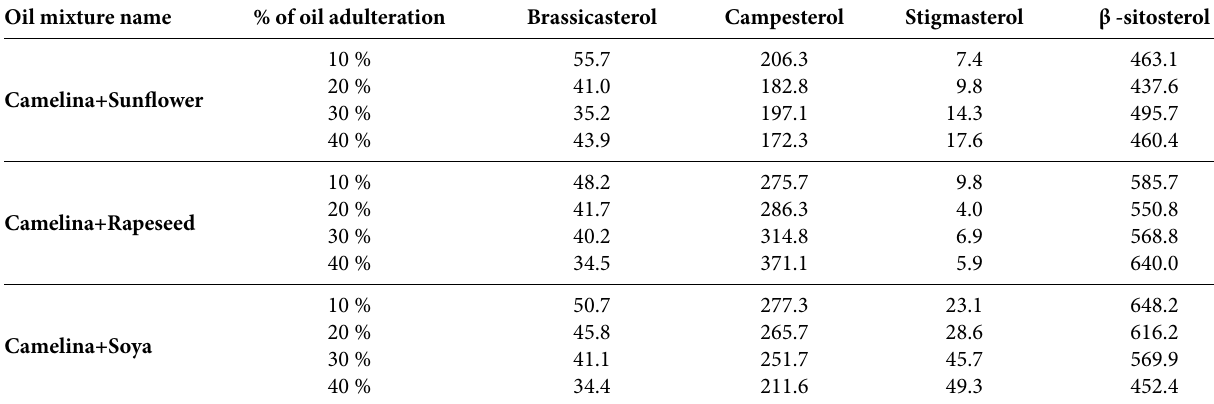
Table 6. Sterol content of adulterated camelina oil (mg 100 g –1 ) with sunflower, rapeseed or soya